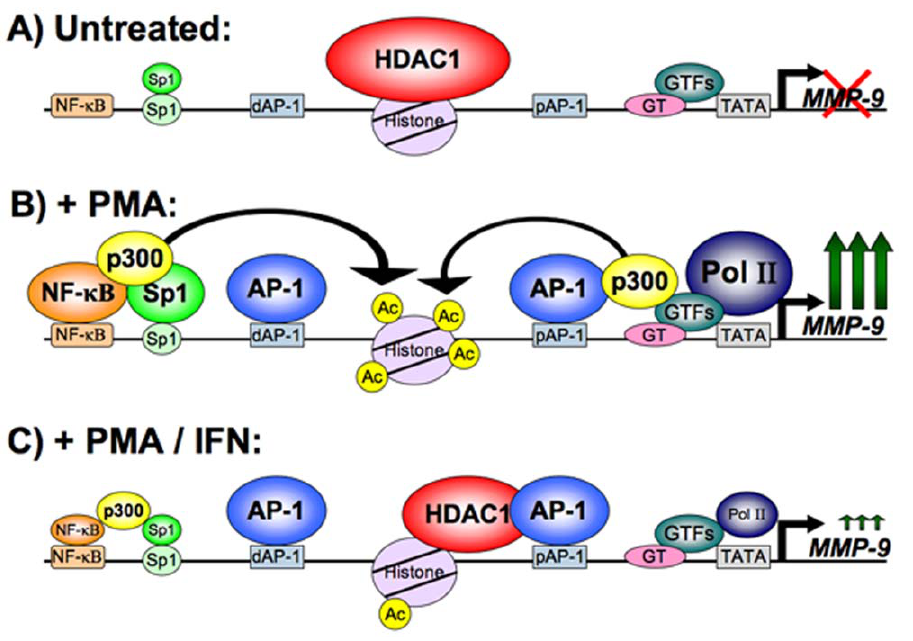
Figure 5. AP-1-mediated recruitment of HDAC1 to MMP-9 promoter in response to IFN b - a schematic model. Based on our results and some of the previously published work [18], this model indicates what is occurring at the MMP-9 promoter under IFN b treatment conditions. ( A ) Under uninduced conditions, there is a basal level of HDAC1 and general transcription factor occupation of the MMP-9 promoter. ( B ) Upon PMA treatment, recruitment of specific transcription factors NF- k B, AP-1, and Sp1 occurs and MMP-9 transcription is induced. Coactivators are also recruited, such as p300, which results in acetylation of the lysine tails of histones. ( C ) IFN b treatment causes HDAC1 to be recruited to the proximal AP-1 site and a corresponding decrease in local acetylation, leading to decreased transcriptional activation of MMP-9. While AP-1 occupation of the MMP-9 promoter is unchanged under IFN b treatment, NF- k B and other specific activators leave the promoter.